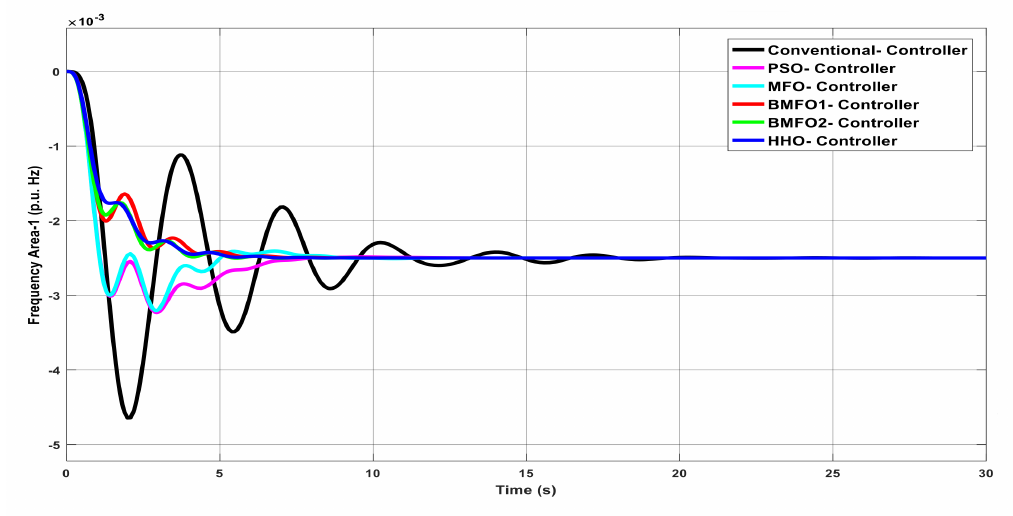
Figure 9. Dynamic response of Area1 frequency with various controllers under bilateral contract.